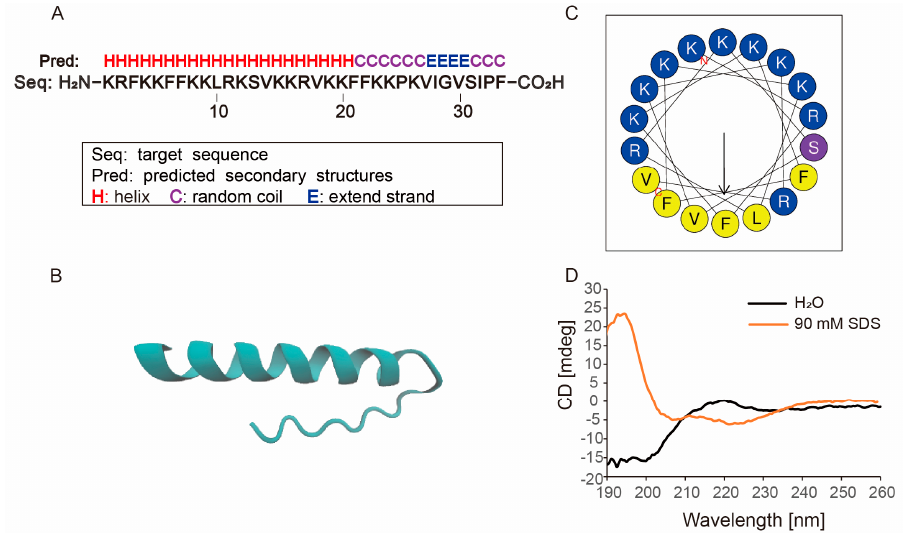
Figure 1. Structure characterization of Hydrostatin-AMP2. ( A ) Primary and secondary structure of Hydrostatin-AMP2; ( B )Three-dimensional structure of Hydrostatin-AMP2 predicted by QUARK; ( C ) Helix-wheel diagram of the represented α -helix region of Hydrostatin-AMP2; ( D ) Circular dichroism spectra of Hydrostatin-AMP2 in H 2 O and 90 mM sodium dodecyl sulfate (SDS).